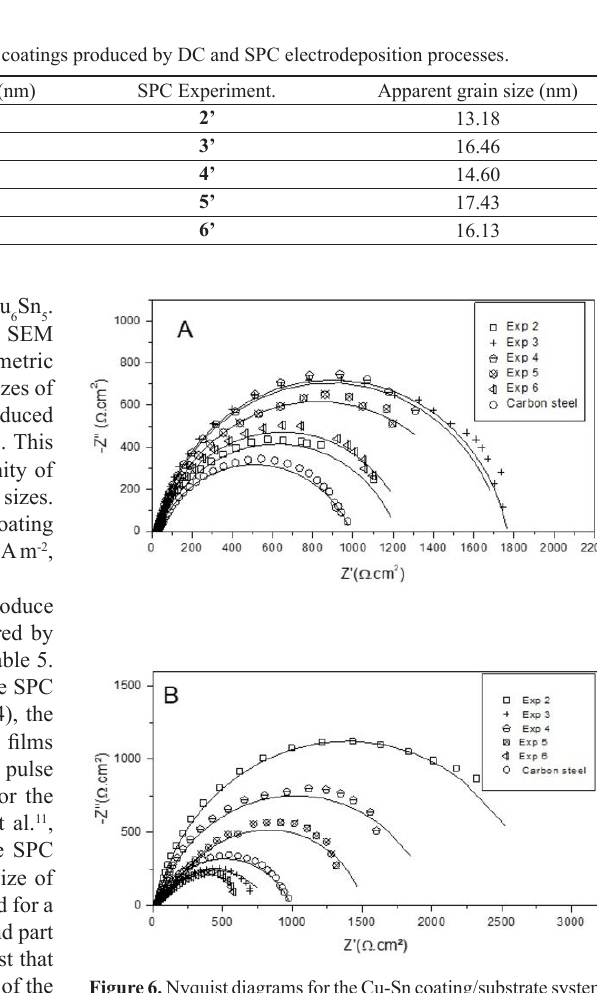
Figure 6. Nyquist diagrams for the Cu-Sn coating/substrate systems produced by (A) DC and (B) SPC and the carbon steel in NaCl 0.5 mol L -1